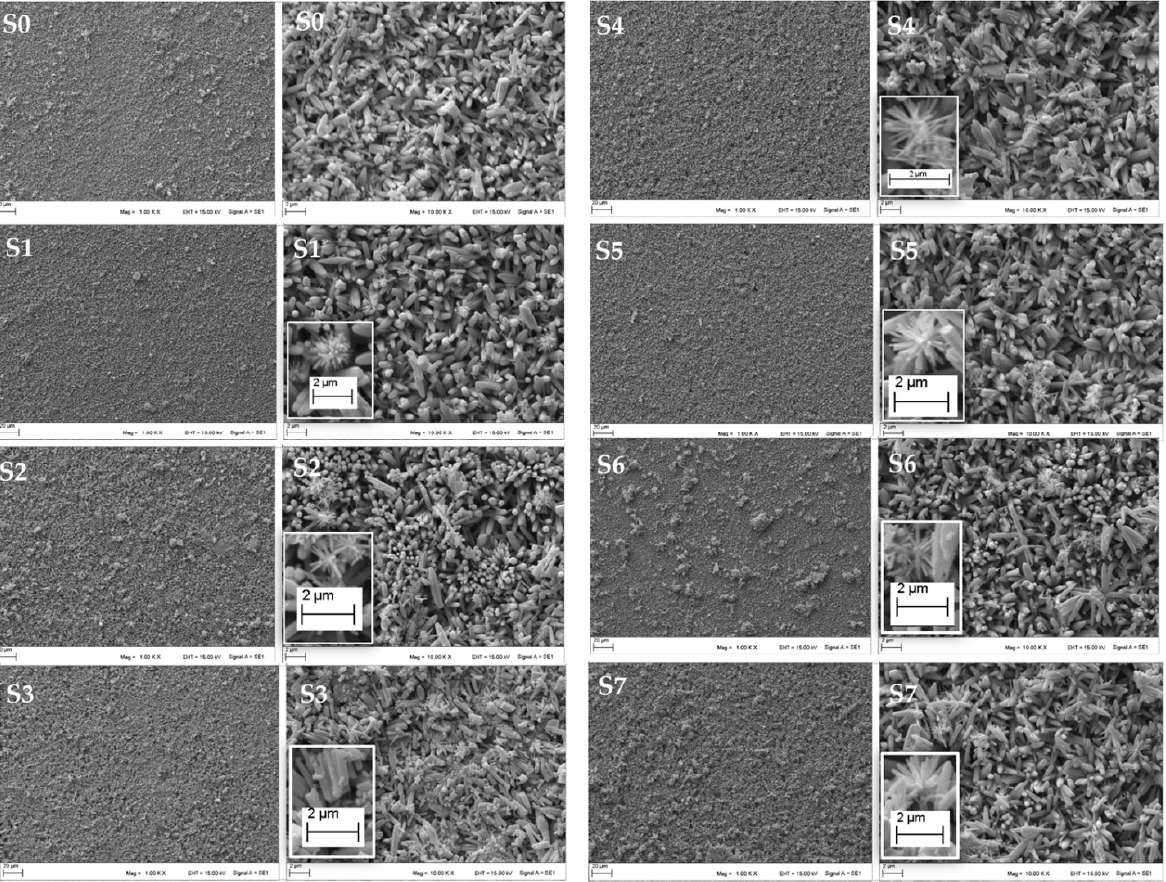
Figure 6. SEM micrographs of the pure ZnO (S0) and B-doped ZnO films (S1: 0.1%; S2: 0.3%; S3: 0.5%; S4: 1.0%; S5: 3.0%; S6: 5.0%; S7: